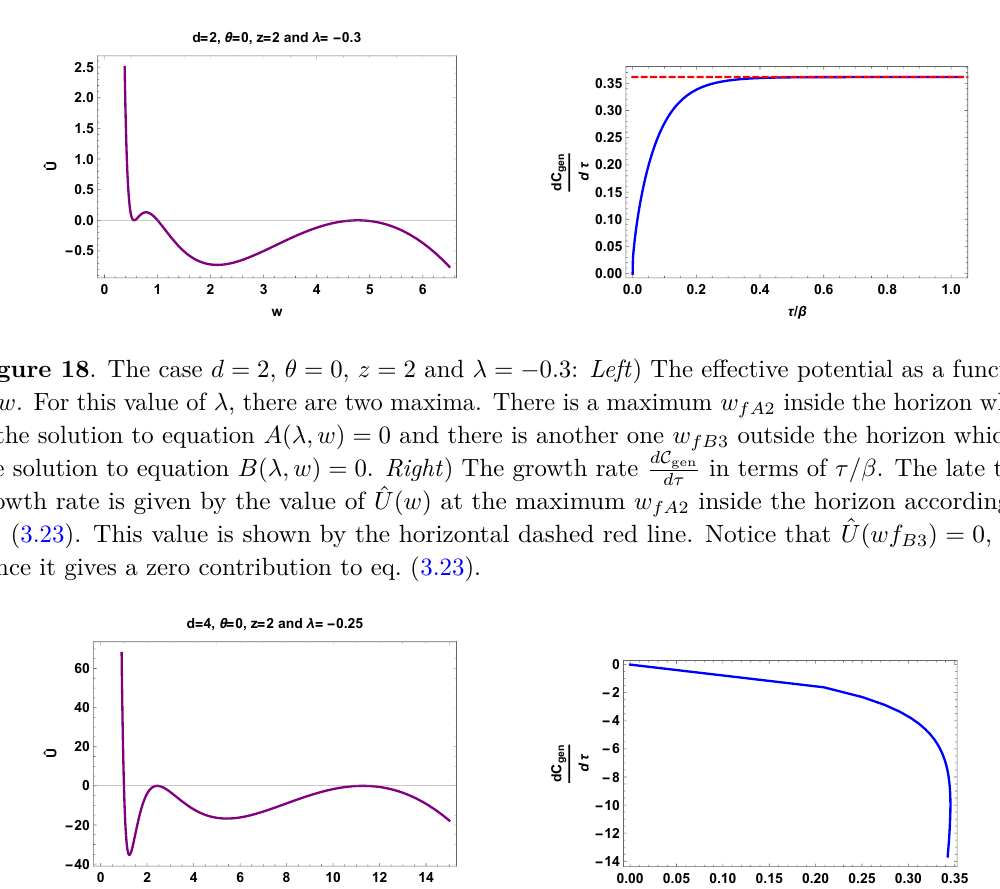
which are located outside the horizon. These fA 1 , 2 in terms of τ/β . It is dτ